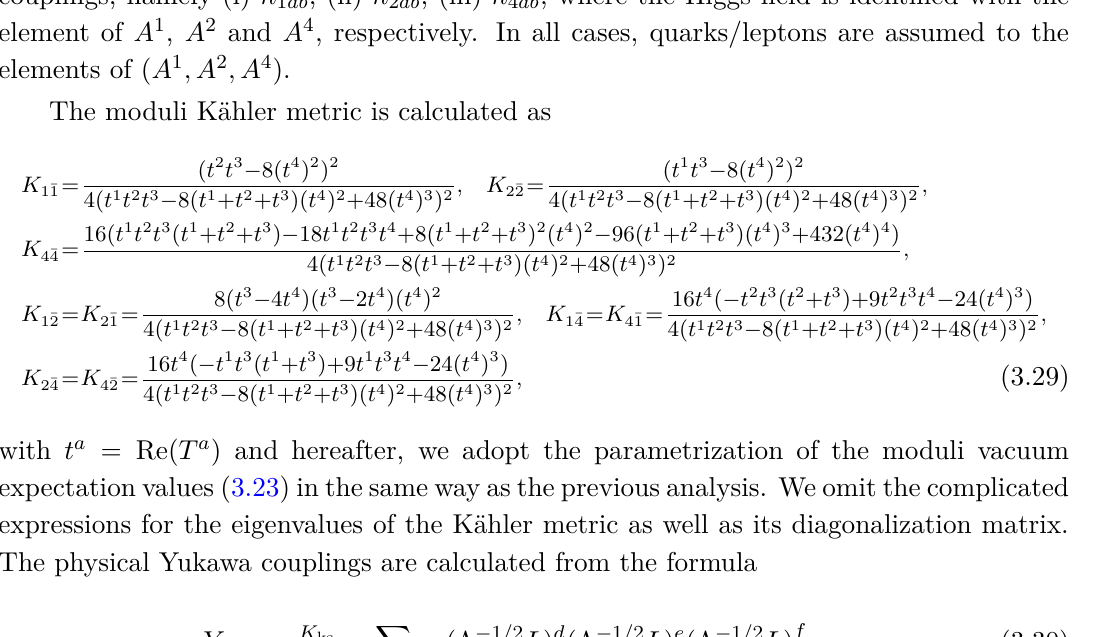
Figure 5 . We draw the ratio of eigenvalues of the rank-two physical Yukawa couplings ( Y maximum one with respect to y and z . The dotted, dashed, and solid curves correspond to the values for 10 − 1 , 10 − 2 , and 10 − 3 , and the blue shaded regions represent the allowed volume 1 < V ≤ 30 .